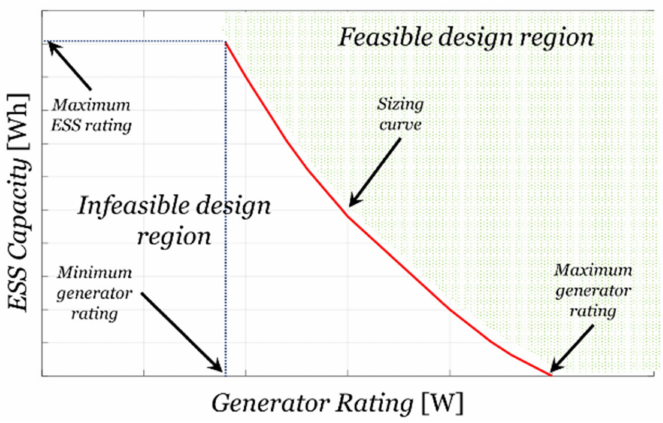
Figure 3. Typical sizing Pareto